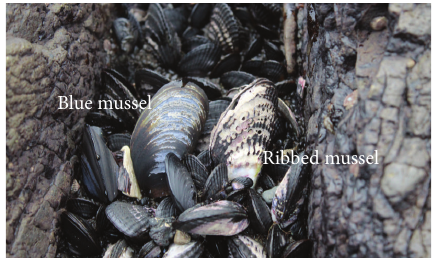
Figure 3: Mixed bed of M. desolationis and A. ater . The specimens were found in mixed beds located at Port-aux-Franc¸ais in the Kerguelen Islands. On the left, the blue mussel M. desolationis . Each valve is elongated with a relatively smooth external surface that displays concentric growth rings. The anterior end is pointed and the posterior end is well rounded. The dorsal margin is convex and theventralisweaklyconcave.Ontheright, A.ater ,alsoknownasthe ribbed mussel, or Cholga or Cholgua, in South America. Its shell is multiform, with a concave ventral edge in most of the specimens. The dorsal edge is notoriously more prominent towards the rear half leaflet. Externally, it presents concentric grooves growth and marked ribs radials with band width decreasing progressively with increasing size.